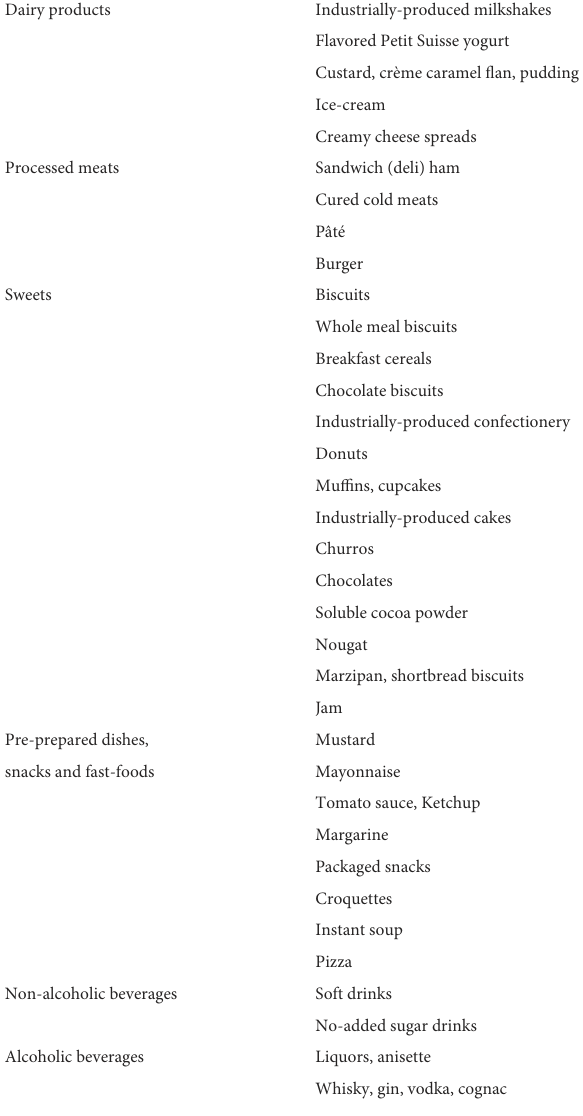
TABLE 1 List of food items from the PREDIMED-Plus food frequency questionnaires allocated in Group 4 (ultra-processed food and drink products) according to NOVA classification